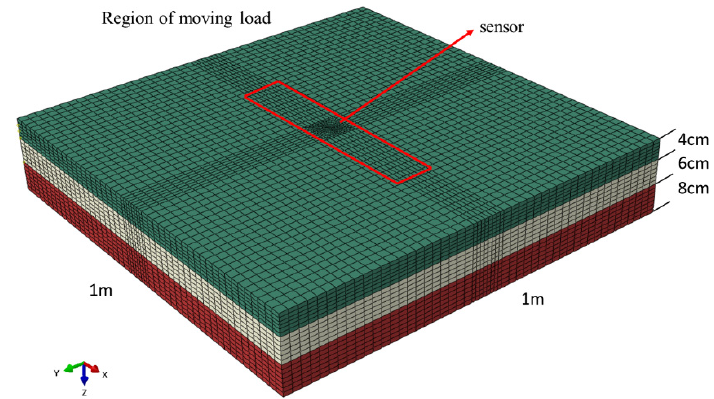
Figure 9. A 3D model of Rollpave pavement with an embedded sensor.